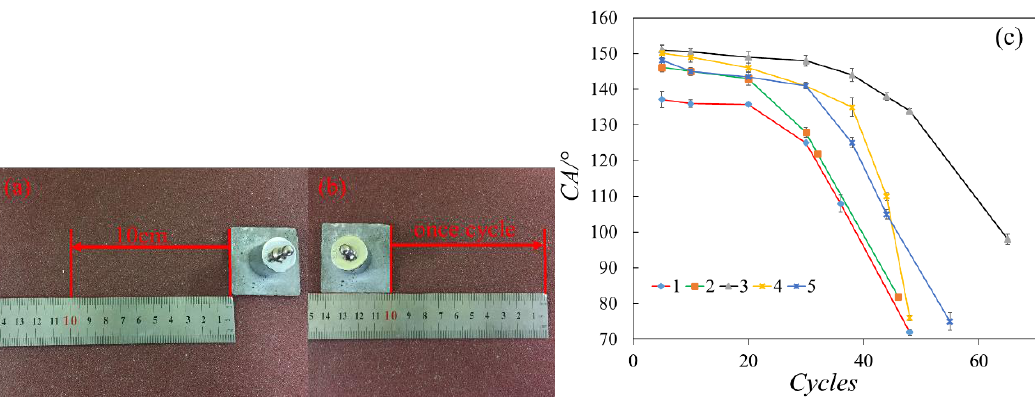
Figure 9. ( a , b ) Schematic image of the mechanical strength and binding force testing procedures; ( c ) WCA changes after friction.